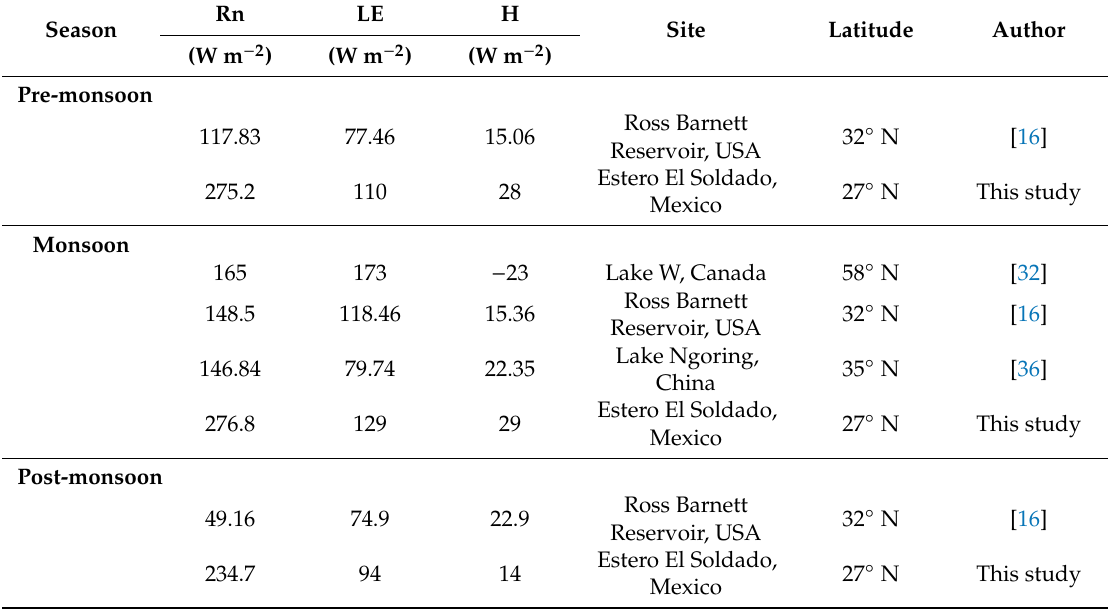
Table 2. Net radiation (Rn), latent heat (LE), and sensible heat (H) from water bodies at di ff erent latitudes. Data were organized based on seasons in this study, were pre-monsoon (January–June), monsoon (July–September), and post-monsoon